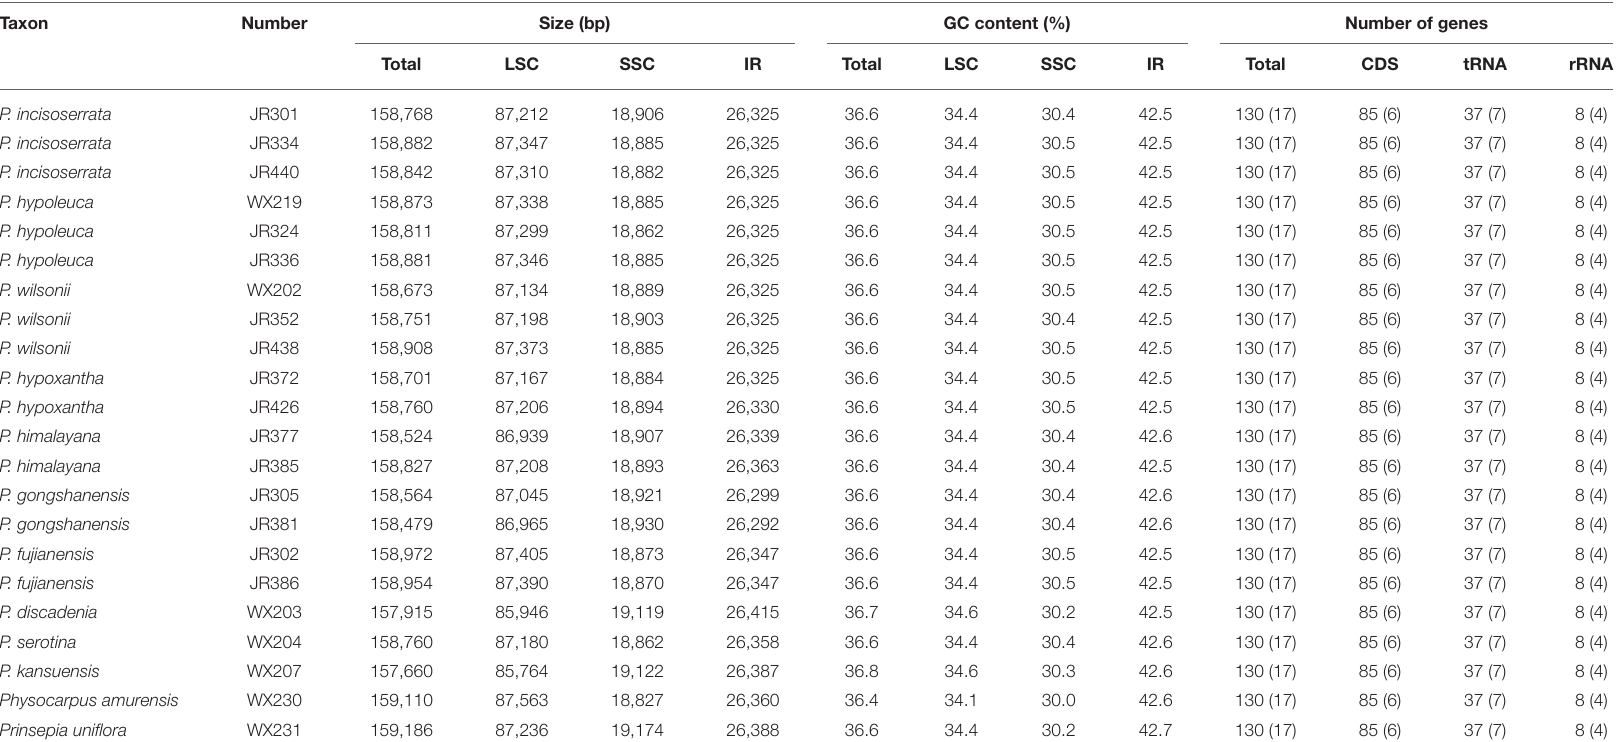
TABLE 2 | Summary information for the plastome sequences of Maddenia